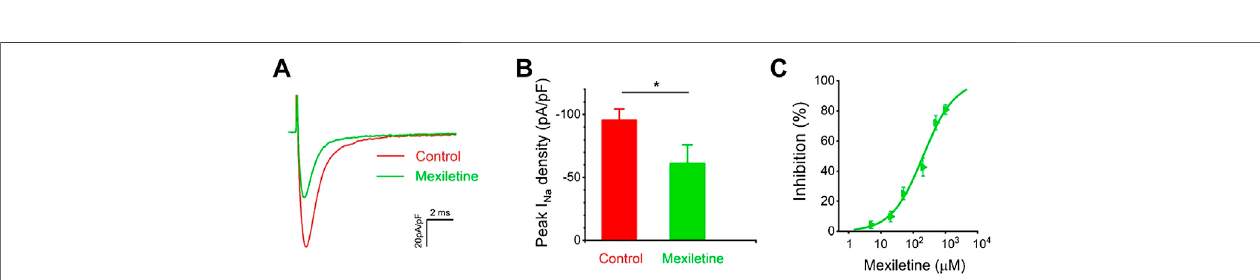
FIGURE 5 | Inhibition of P1090L mutation currents by mexiletine. (A) . Representative current traces of P1090L recorded in the absence (Control) and presence of 200 µMmexiletine.Currentswereelicitedbyatestpulseof − 20 mVfromaholdingpotentialof − 120 mV. (B) .Quanti fi cationofP1090Lmutationcurrentdensitieswithout (Control) or with the treatment of 200 µM mexiletine. n = 6 for each group, data are presented as the mean ± SEM. * p < 0.05. (C) . Dose-dependent effects of mexiletine on P1090L sodium current inhibition ( n = 4-6 for each concentration; data are presented as the mean ± SEM). Curves are Hill fi ts of the data points.